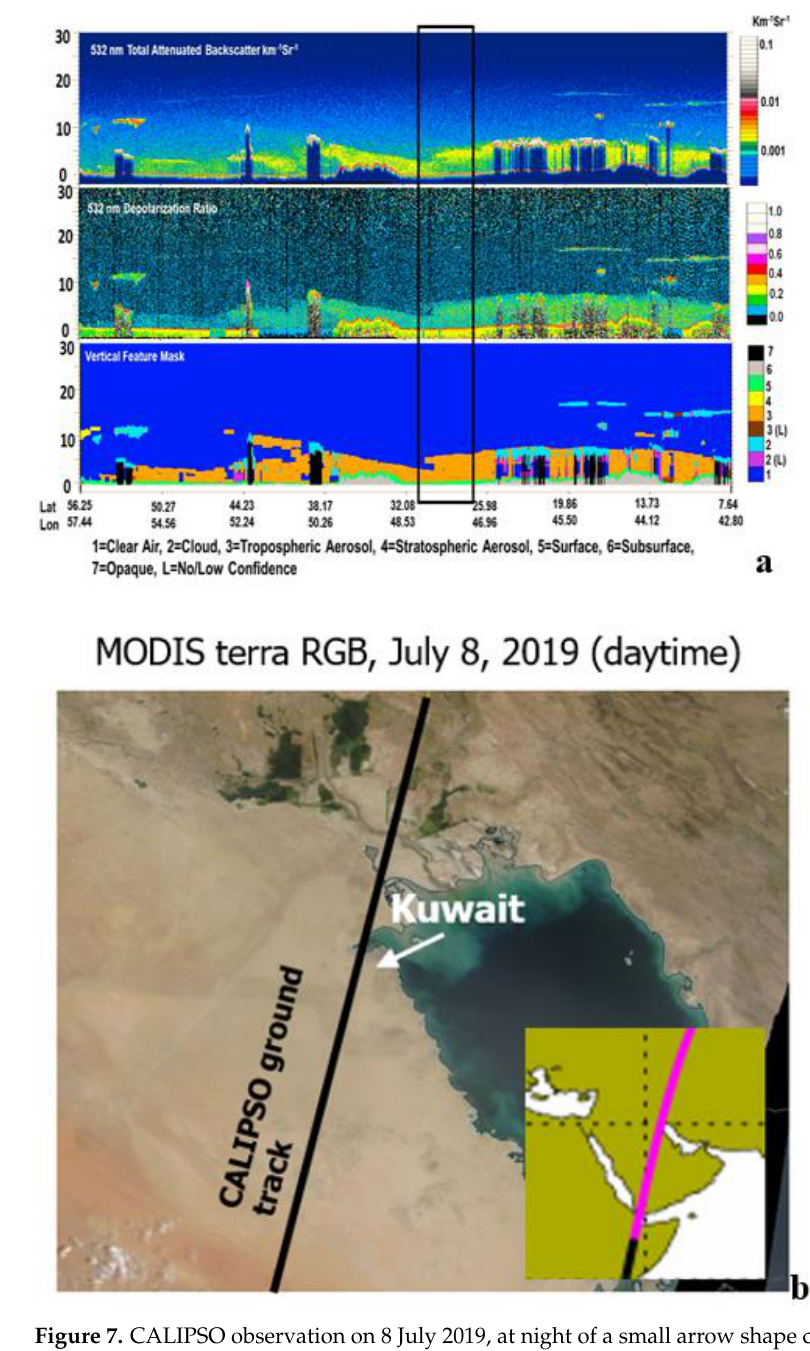
Figure 7. CALIPSO observation on 8 July 2019, at night of a small arrow shape curved SDS type from the area (A) towards Kuwait and the northern Arabian Gulf ( a ) and the vertical feature mask shows that the dust extended from the surface to a height of ~6 km near Kuwait City ( b ).